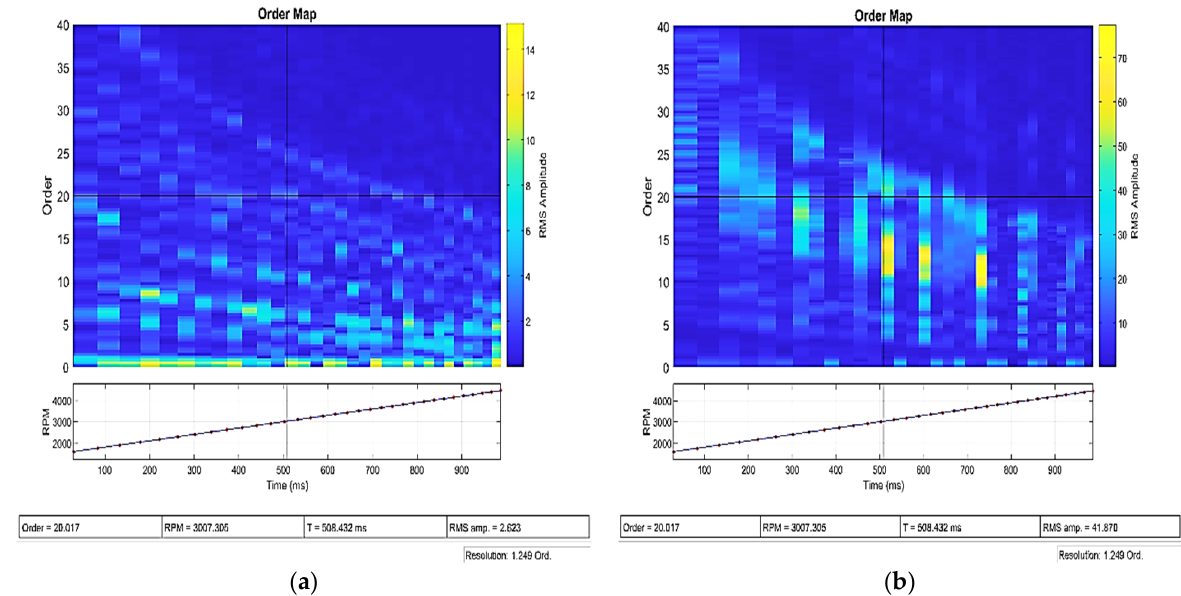
Figure 20. Examples of the generated order maps for bearing vibrations with ( a ) normal condition (NO) and ( b ) inner race fault (IR) under variable speed (25–75 rpm).